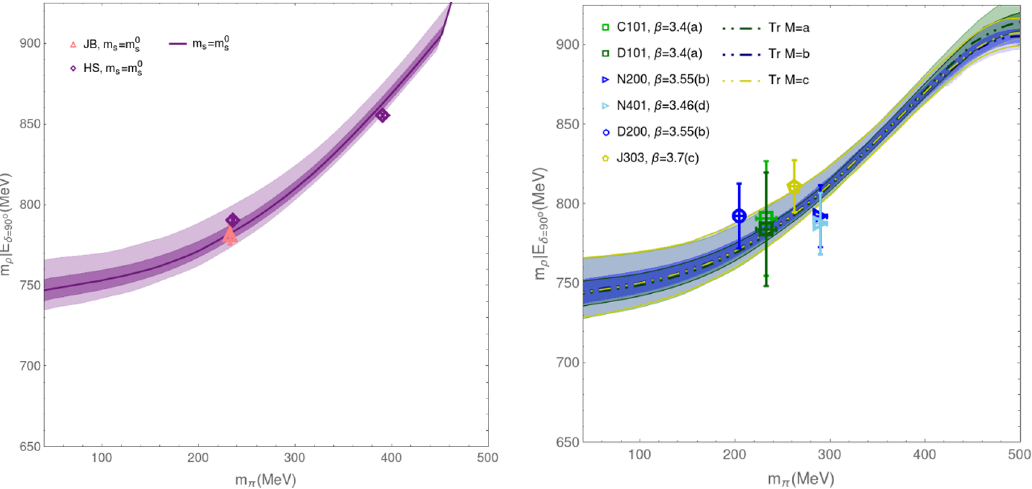
Figure 26 . The (cid:26) -meson mass as a function of the pion mass over the m s = m 0 Tr M = Tr M 0 (right) trajectories in comparison with the lattice